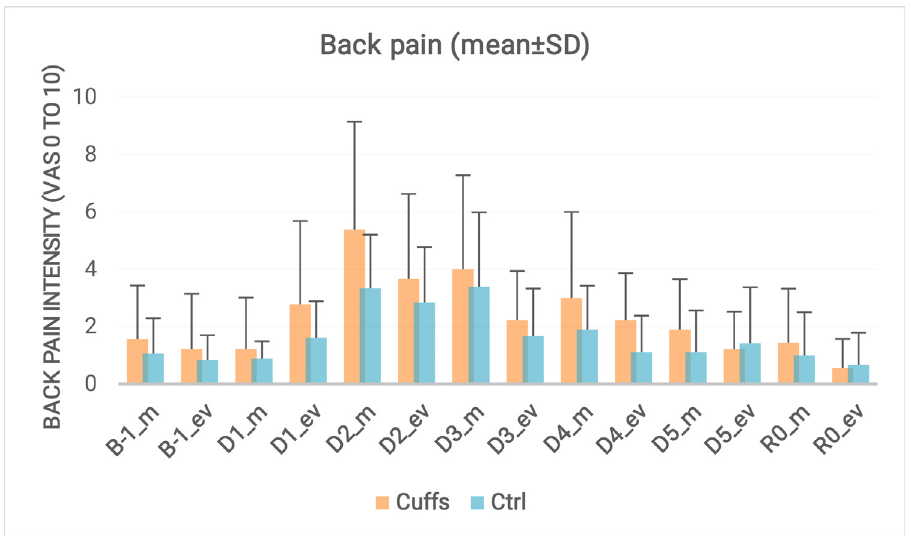
Figure 6. Back pain intensity (0 to 10 on a visual analog scale). Data collection before (B-1) to recovery (R0) every day for five days of dry immersion (D 1 to D 5 ) in the morning (m) and in the evening (ev). Two-way analysis of variance (ANOVA) revealed a significant global effect of DI ( p < 0.0001), and no effect of countermeasure ( p = 0.34).